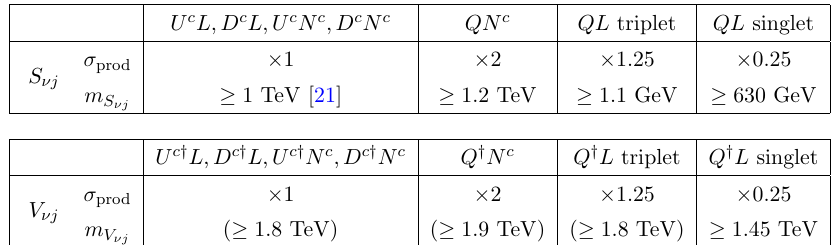
Table 2 . ( Upper ) 95% CL lower limit on the mass of scalar MLQs S